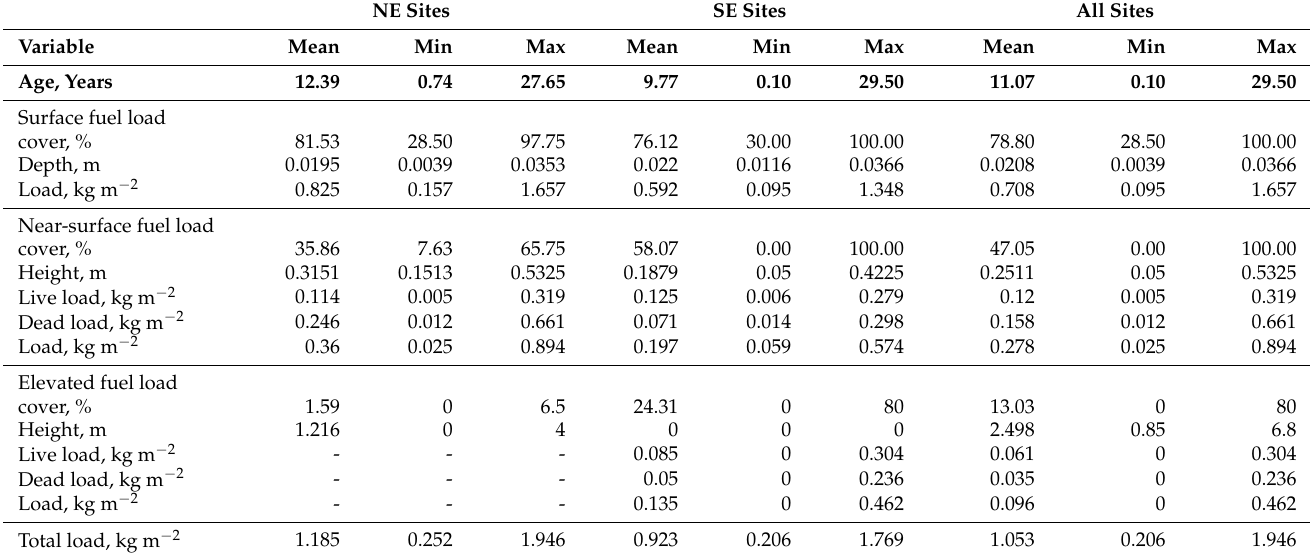
Table 1. Fuel load data range.